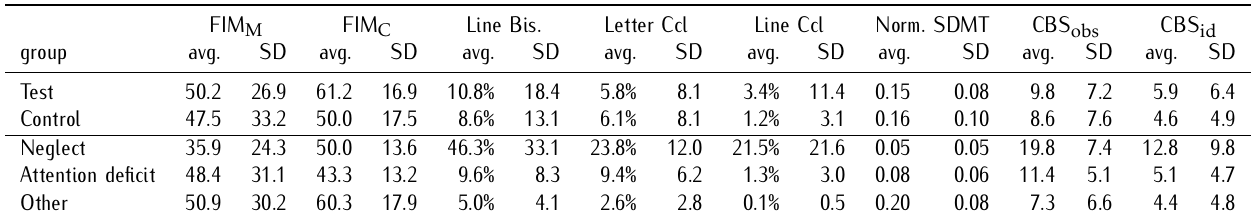
Table 3. Participants’ neuropsychological test scores at entry tallied as in Table 2 FIM M FIM C Line